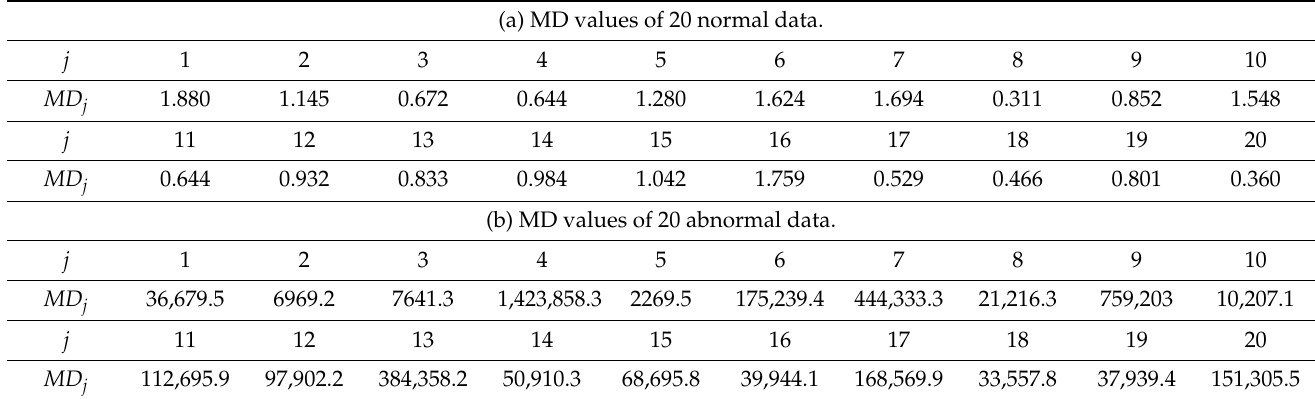
Table 5. Mahalanobis distances of training